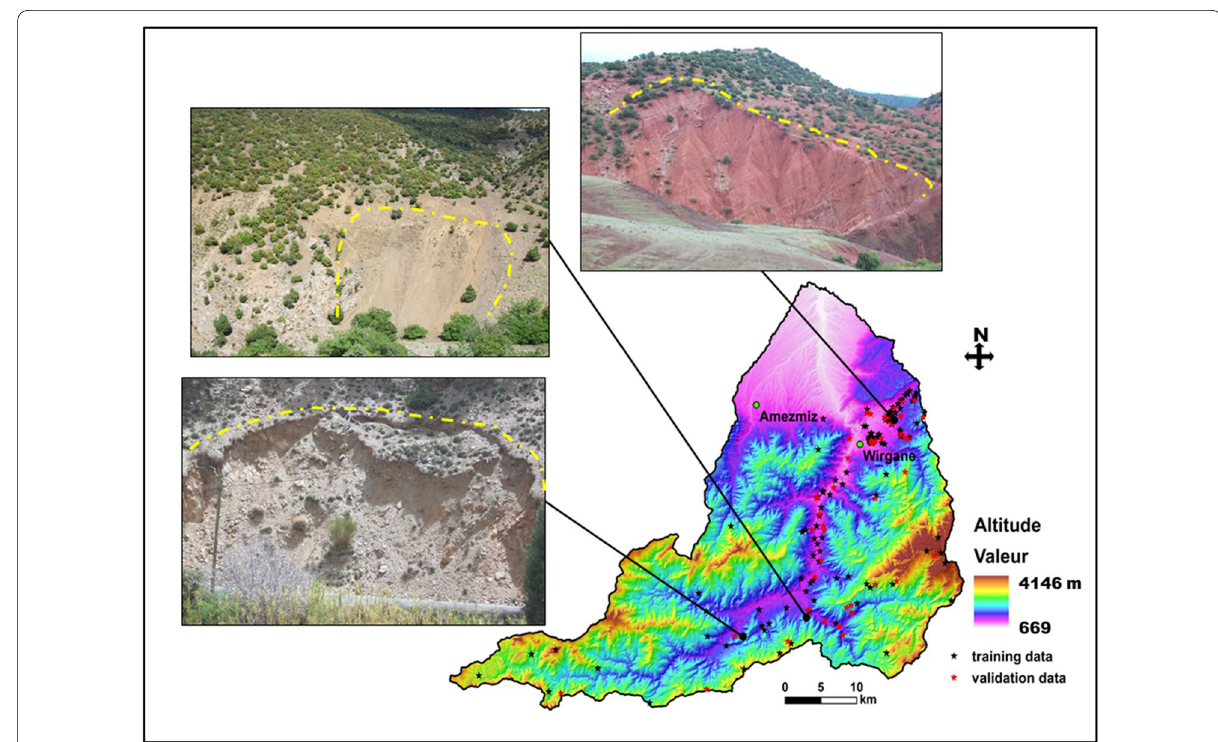
Fig. 3 Inventory map and examples of landslides in the N’fis basin